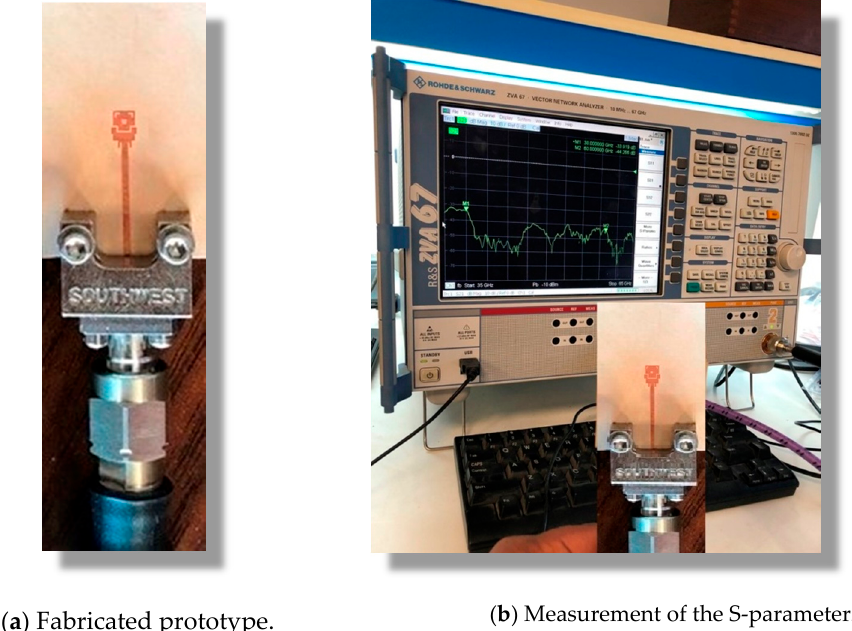
Figure 13. Measurement of the scattering parameter | S 11 | of the proposed dual-band patch antenna using the vector network analyzer (VNA; Rhode and Schwartz model ZVA67).